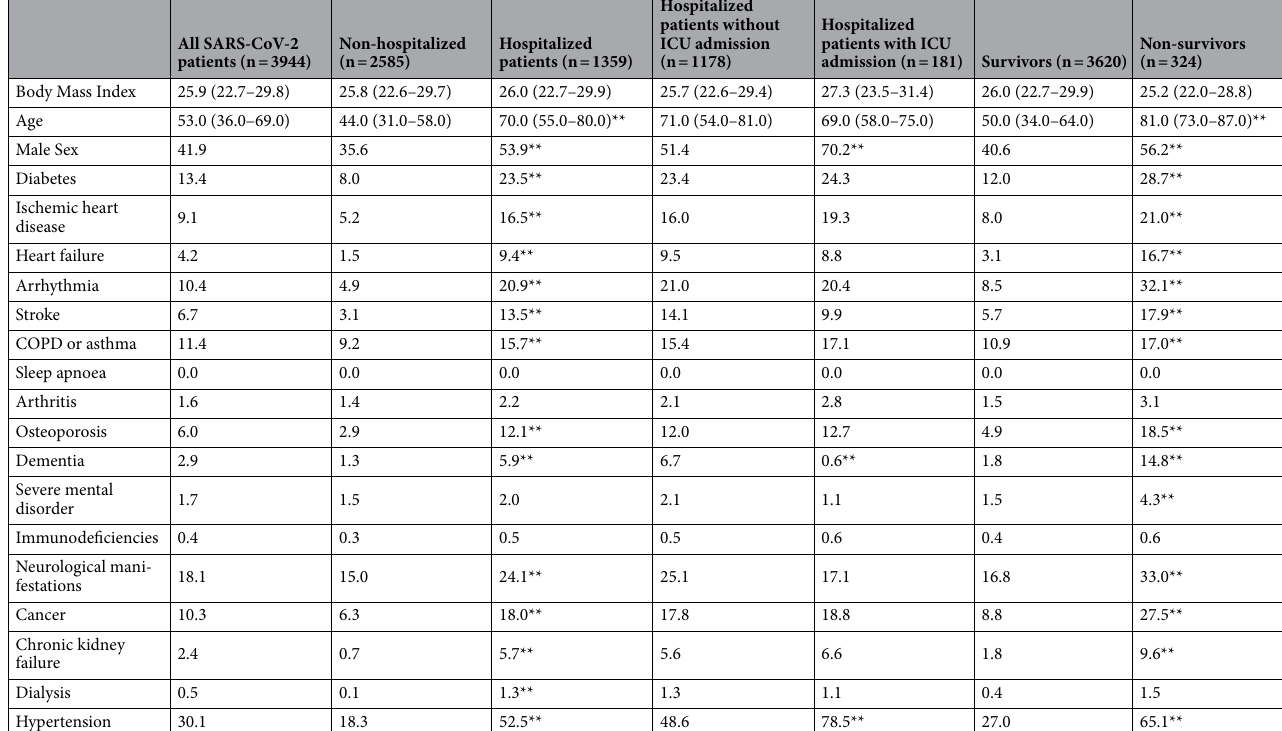
Table 1. Demographic information on the group of SARS-CoV-2 positive patients, including information on pre-existing comorbidities. Supplementary Table S2 holds information on diagnoses codes included in the individual comorbidity classifications. The table presents information on the full cohort (admitted and non- admitted SARS-CoV-2 positive patients) as well as subgroups admitted to a hospital and Intensive Care Unit (ICU) respectively. Furthermore, differential demographics between survivors and non-survivors (in-hospital mortality) is presented. Continuous variables are presented as medians with (interquartile range). COPD chronic obstructive pulmonary disease. ** p < 0.001 when subgroups are compared (e.g. hospitalized vs. non- hospitalized, ICU vs. non-ICU, survivors vs.